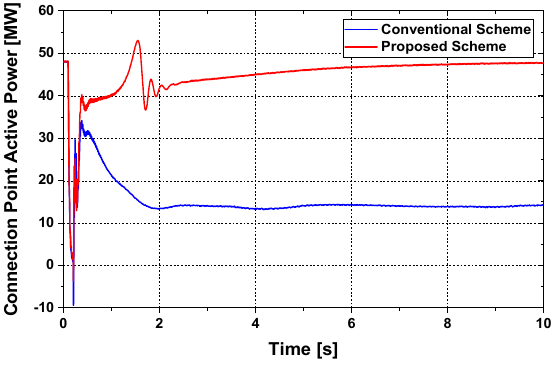
Figure 14. Active power response at the connection point. Figures 15 and 16 represent the response of active power of SCIG and DFIG, respec- tively, where Case 2 showed better performance. Figure 17 illustrated the rotor speed response of DFIG.